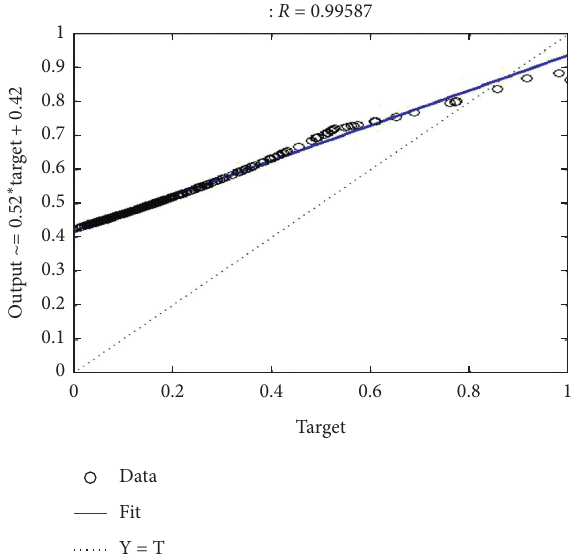
Figure 11: Performance regression plot of the SVMR